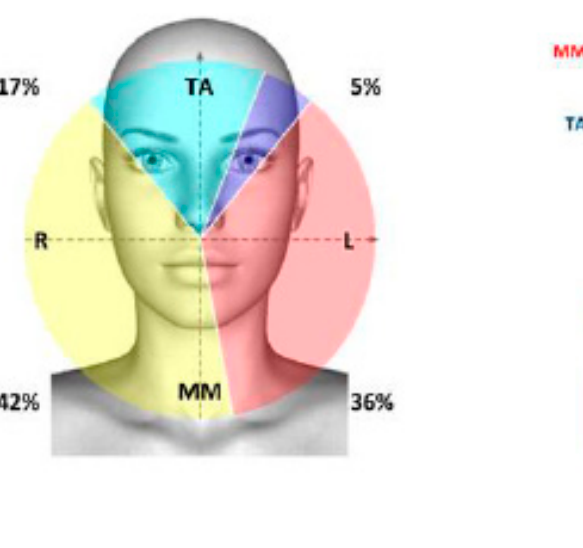
Figure 21. Surface electromyography in mandibular rest position.